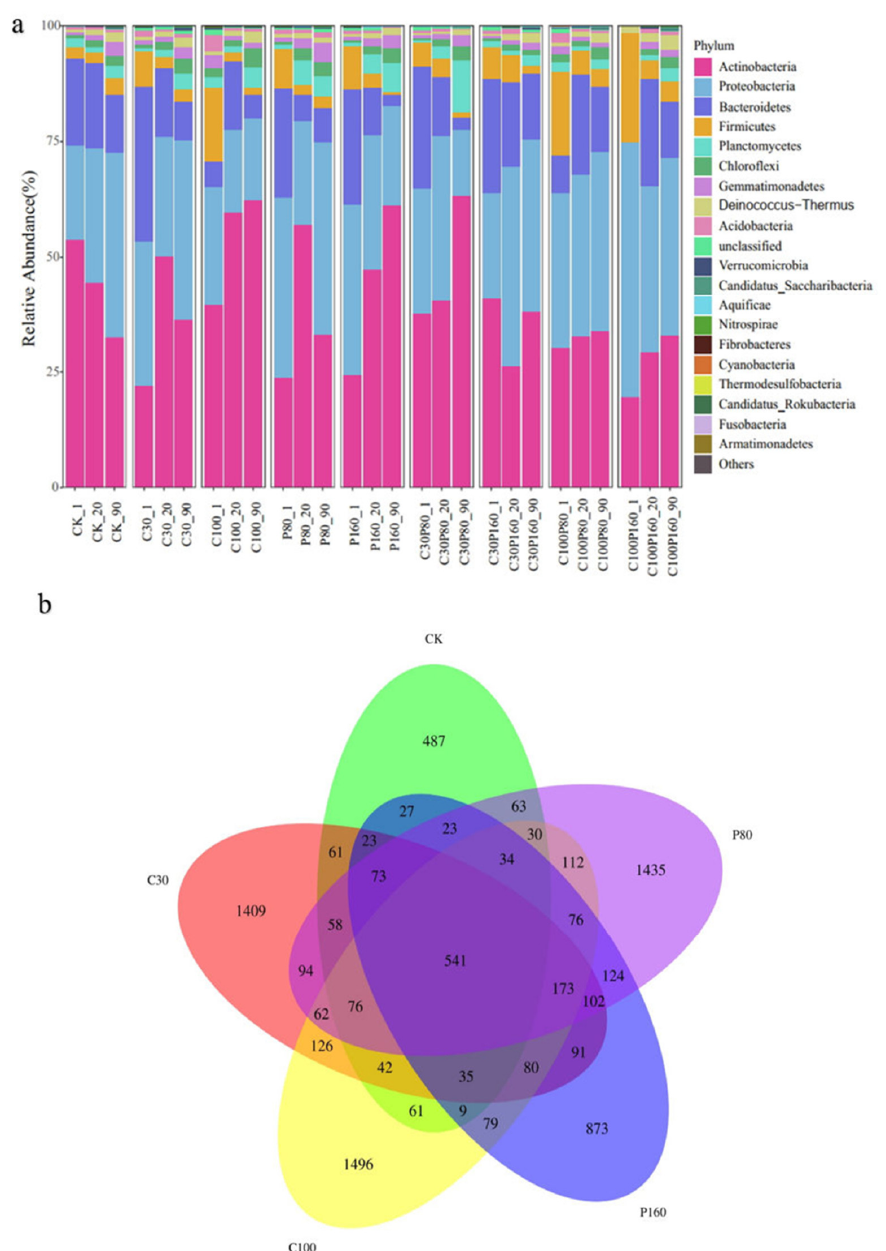
Figure 3. ( a ) The relative population of the top 20 bacteria at the phylum level in the soil; ( b ) Venn diagram showing different OTUs. Note: taking CK-90 as an example, it represents the sample taken by the CK experimental group on the 90th day. The numbers in the Venn diagram represent the number of OTUs.